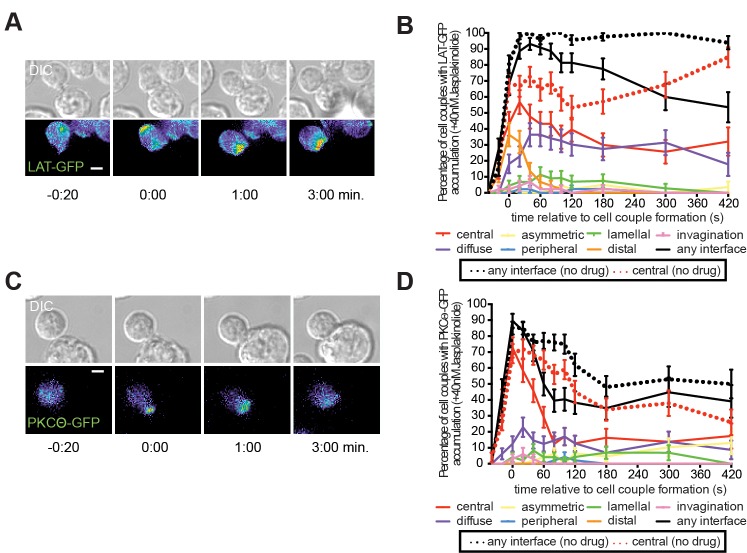
Low dose JASP treatment interferes less severely with central signaling localization.(A, C) Representative interactions of a 5C.C7 T cell expressing LAT-GFP (A) or PKCθ-GFP (C) with 40nM Jasplakinolide (S6 and S7 Videos) are given similar to Fig 1B. (B, D) The corresponding pattern classifications are given similar to Fig 3C (number of cell couples analyzed across multiple independent experiments, n = 44, n = 48). Control ‘any interface’ and ‘central’ accumulation curves [3] are plotted as a reference in broken lines. Error bars represent s.e.m..